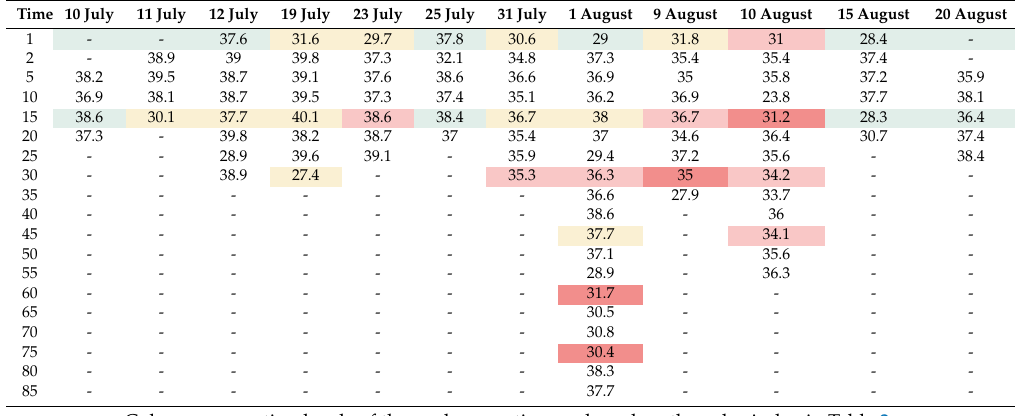
Colors representing levels of thermal perception are based on the color index in Table